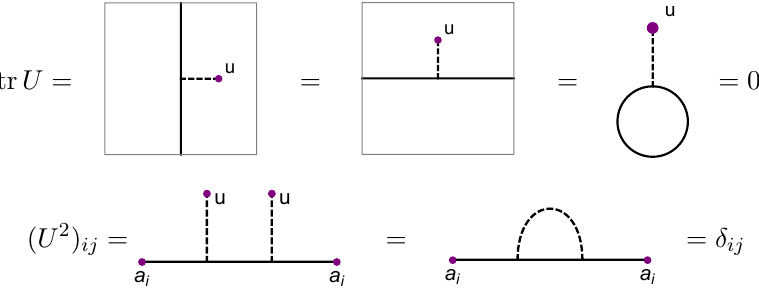
Figure 46 . Structure constants U ij and C i X and the solid line stands for Y .